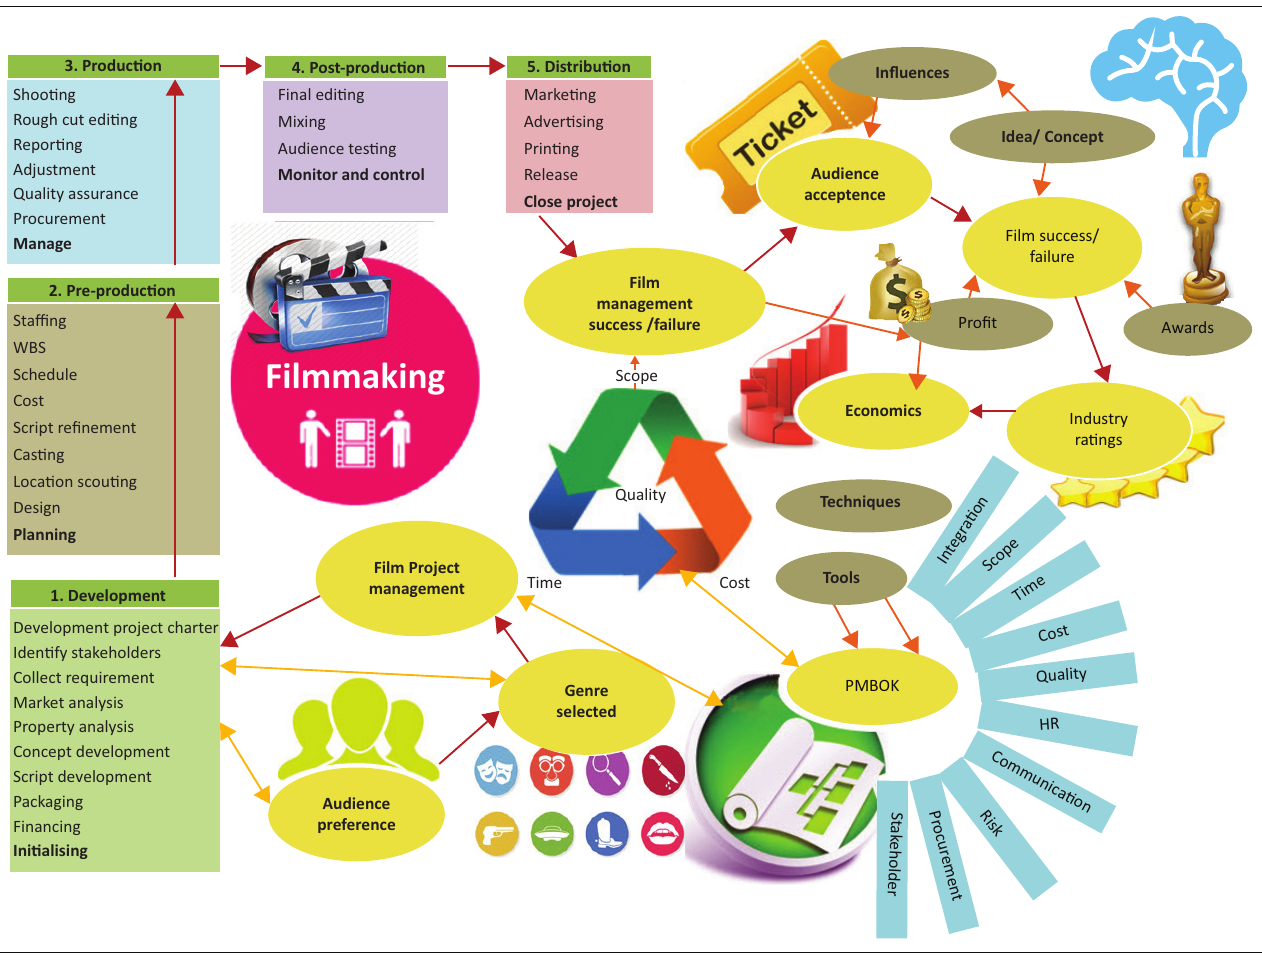
FIGURE 7: The motion picture production project management